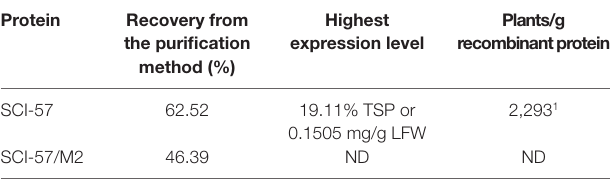
TABLE 2 | Yield of the SCI-57 expression and purification.